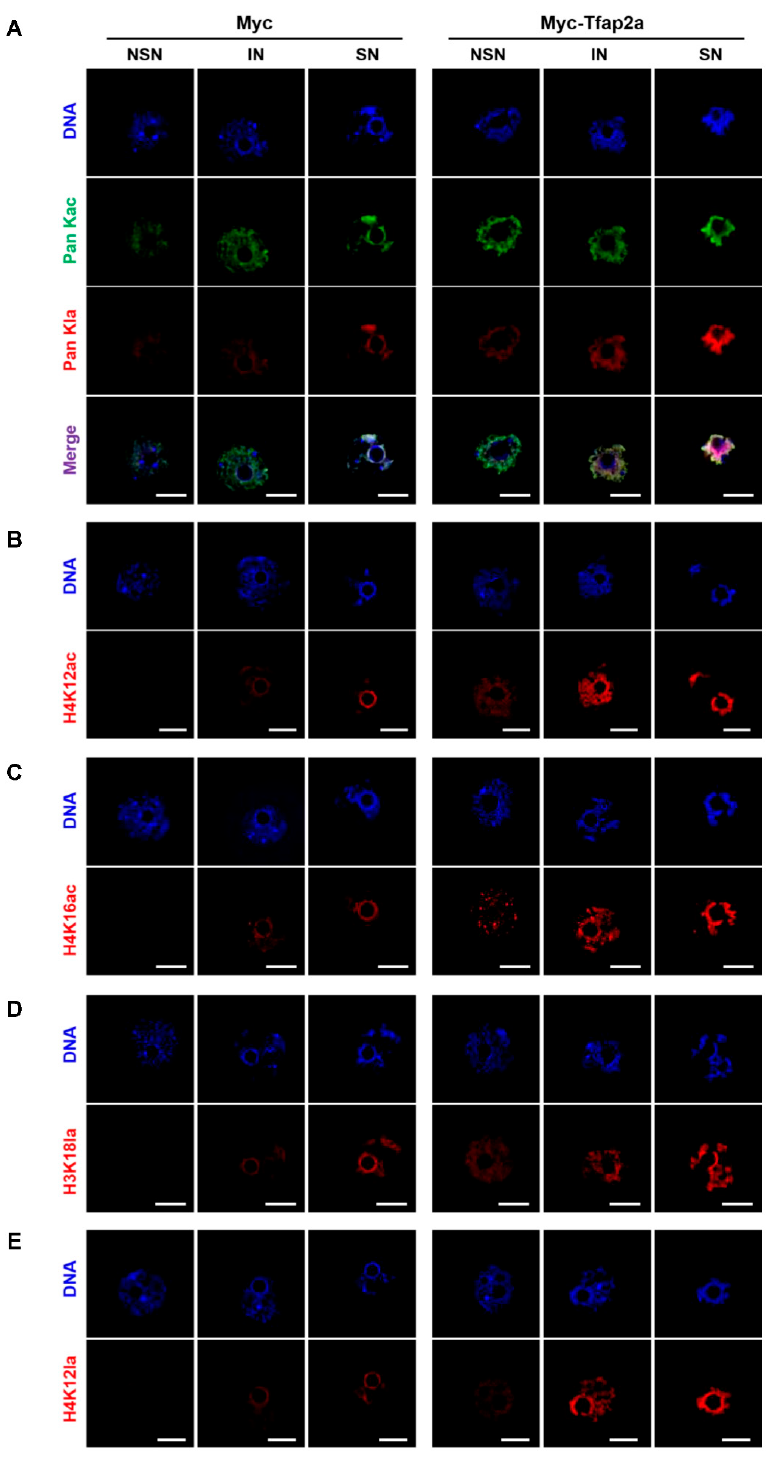
Figure 7. Representative pictures of histone acetylation and histone lactylation in mouse GV-stage oocytes after overexpression of Myc and Myc-Tfap2a. The pan histone acetylation and the pan histone lactylation ( A ), H4K12ac ( B ), H4K16ac ( C ), H3K18la ( D ), and H4K12la ( E ) in mouse oocytes at the GV stage. Pan histone acetylation is shown in green, whereas pan histone lactylation, H4K12ac, H4K16ac, H3K18la, and H4K12la are shown in red. The DNA was stained with Hoechst 33342 (blue). Scale bars = 20 µ